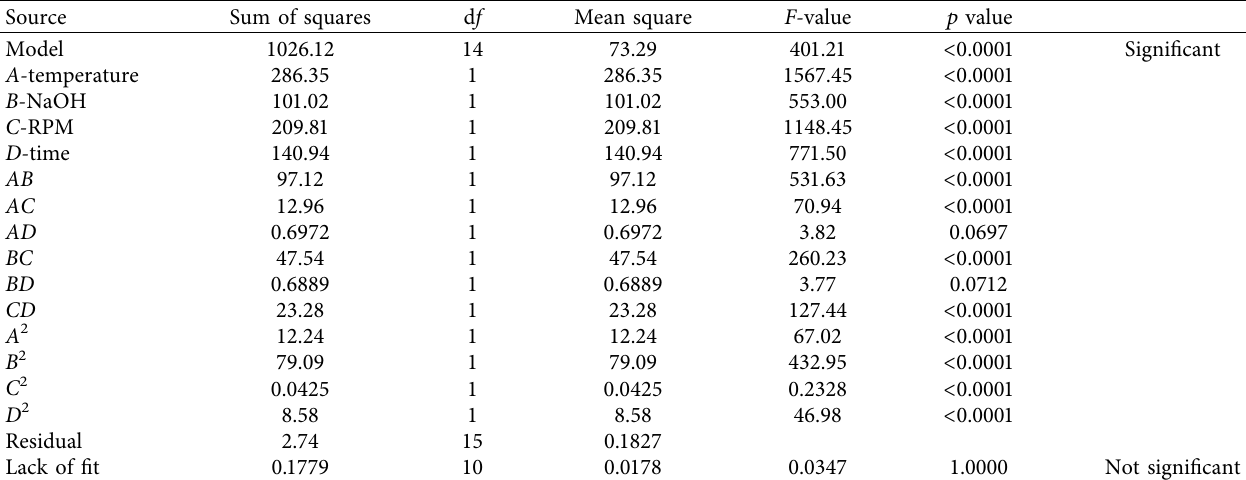
Table 3: ANOVA of fitted model for the yield of biosilica.